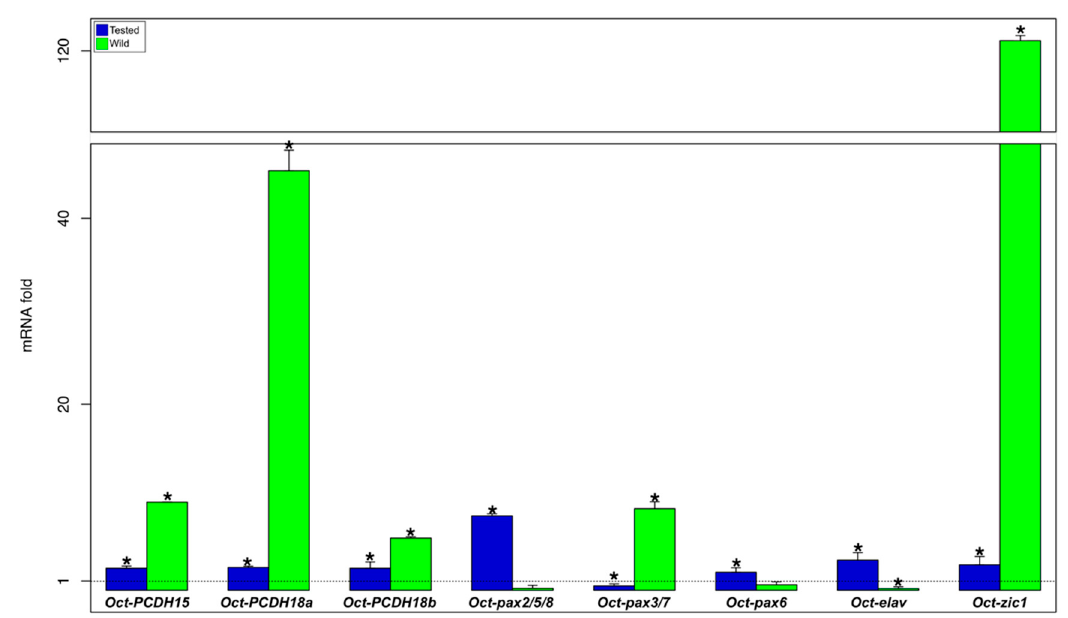
Figure 5. Gene expression analysis in the subesophageal mass. Relative mRNA fold change in gene expression in tested (blue) and wild (green) octopus is compared to the control (N = 6/group; dot line set y = 1). * asterisk indicates that the difference vs. control group is statistically significant (Wilcoxon-test, p < 0.05). Error bars represent the SEM.